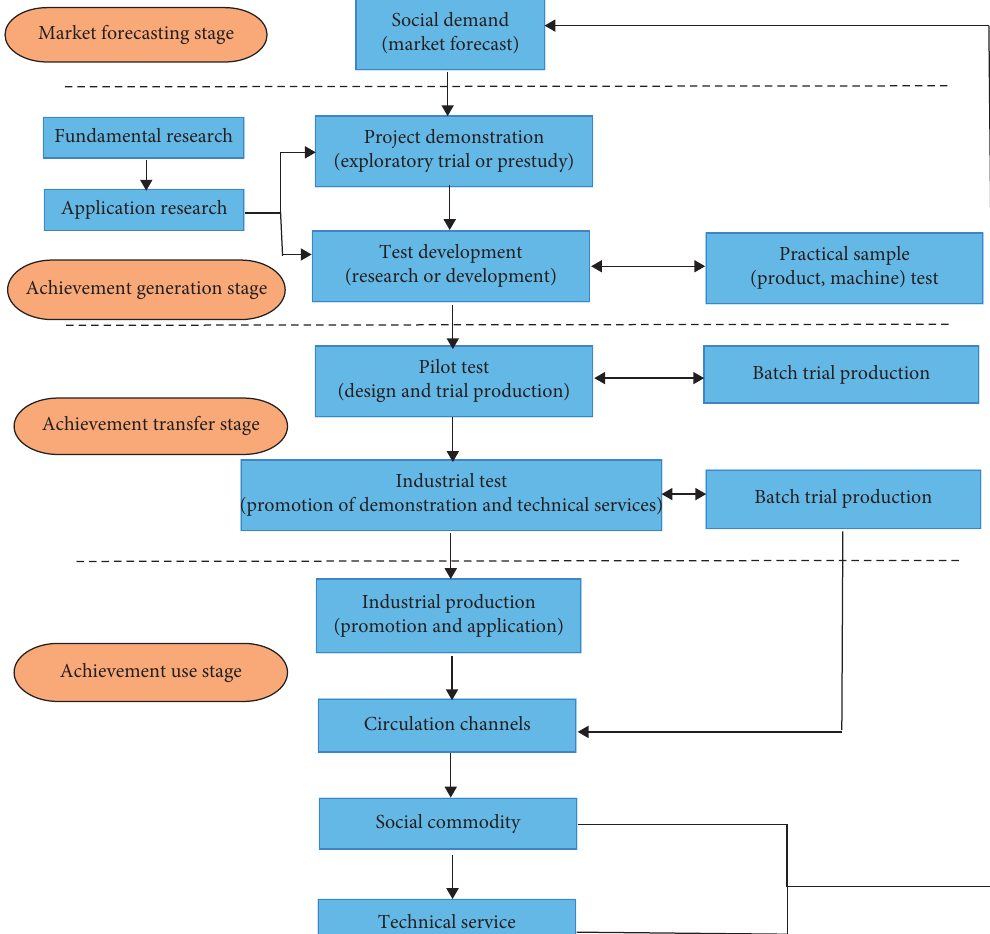
Figure 1: Chart of the basic process of industrialization of science and technology